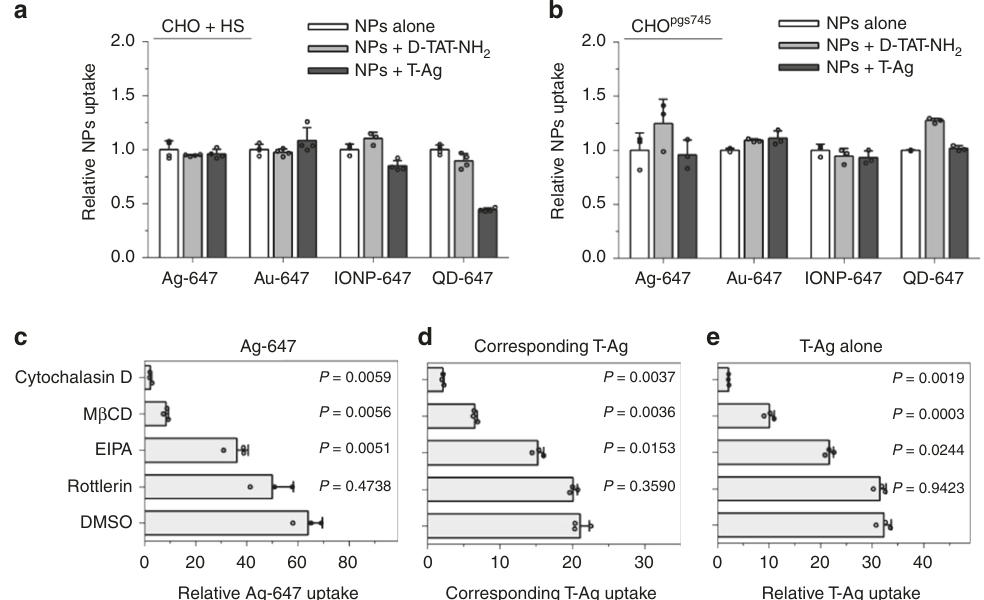
Fig. 2 Mechanistic studies of bystander uptake. a Bystander uptake is completely abolished by HS. CHO cells were incubated with HS prior to the addition of the indicated bystander NPs ( x -axis) alone, or with D-TAT-NH 2 or T-Ag. The fl uorescence intensity of bystander NPs per cell was quanti fi ed by fl ow cytometry and normalized to that of bystander NPs alone ( y -axis). Data presented here are mean ± s.d. of three independent experiments ( n = 3). b The indicated bystander NPs ( x -axis) were incubated with CHO pgs745 cells with D-TAT-NH 2 or T-Ag, and bystander NPs uptake ( y -axis) was quanti fi ed as described in a . Data shown are mean ± s.d. of three independent experiments ( n = 3). c – e CHO cells were pre-treated with indicated MP inhibitors dissolved in DMSO (y-axis) before incubating with T-Ag and Ag-647. The fl uorescence intensity of AgNPs was quanti fi ed by fl ow cytometry and normalized to that of Ag-647 (for Ag-647 bystander uptake) or Ag-555 (for T-Ag uptake) alone ( x -axis). c bystander uptake of Ag-647; d corresponding T-Ag uptake in c ; e the uptake of T-Ag alone. All quanti fi ed data were analyzed using one-way ANOVA with Tukey ’ s multiple comparisons test comparing DMSO versus other MP inhibitors and are expressed as mean ± s.d. of three independent experiments ( n = 3). One-way ANOVA, c F = 91.712, P = 0.0085; d F = 829.55, P = 0.0001; e F = 641.67, P < 0.0001. Source data are provided as a Source Data fi